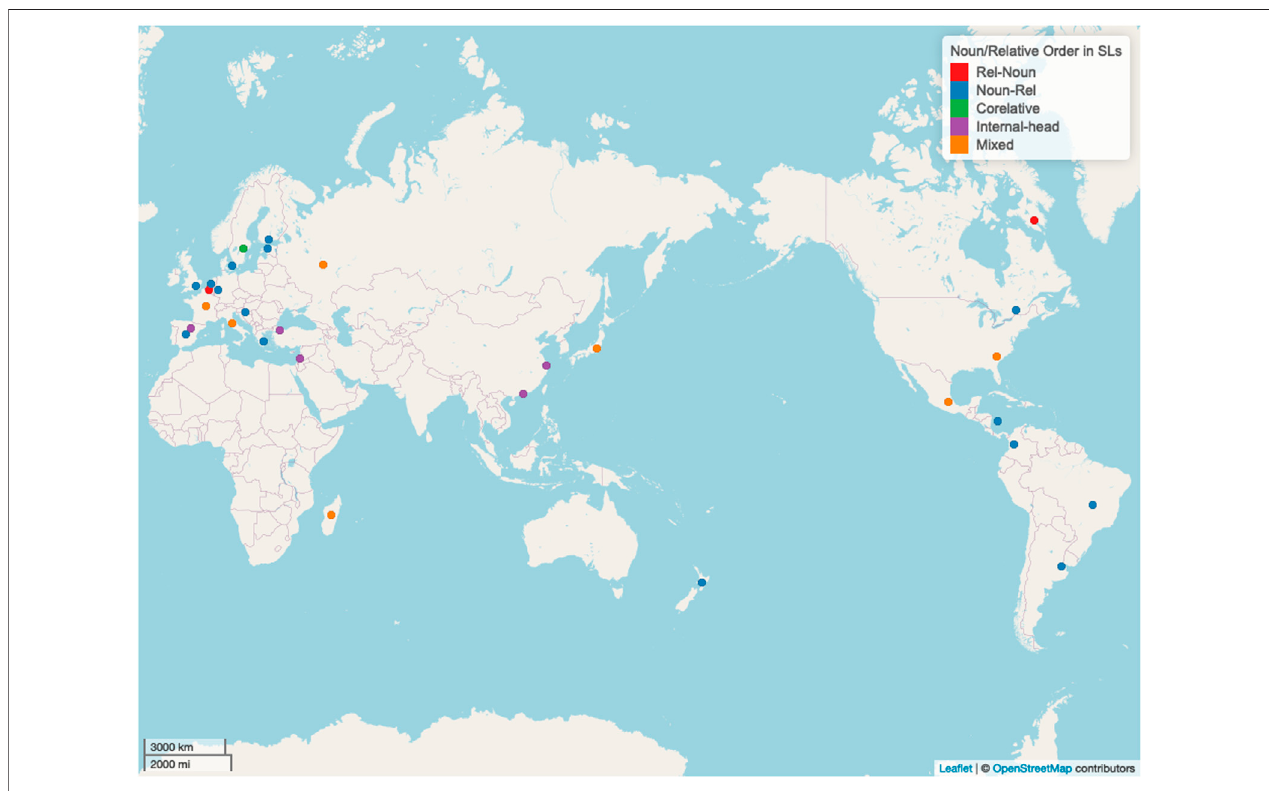
FIGURE 7 | Map of noun/relative order in sign